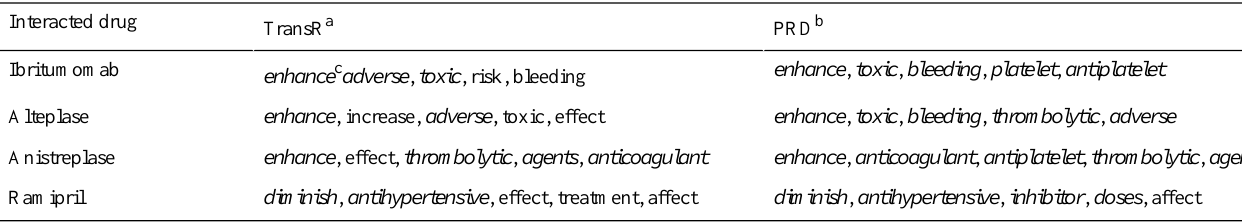
Table 3. Rich drug-drug interaction predictions for acetylsalicylic acid.